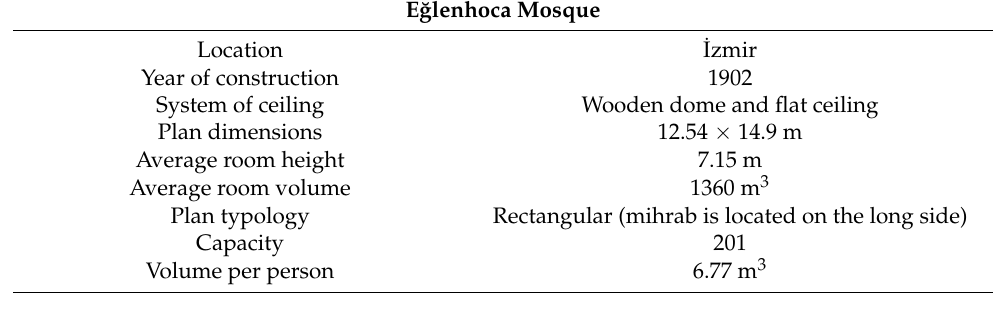
Table 5. The architectural features of E ğ lenhoca Mosque .